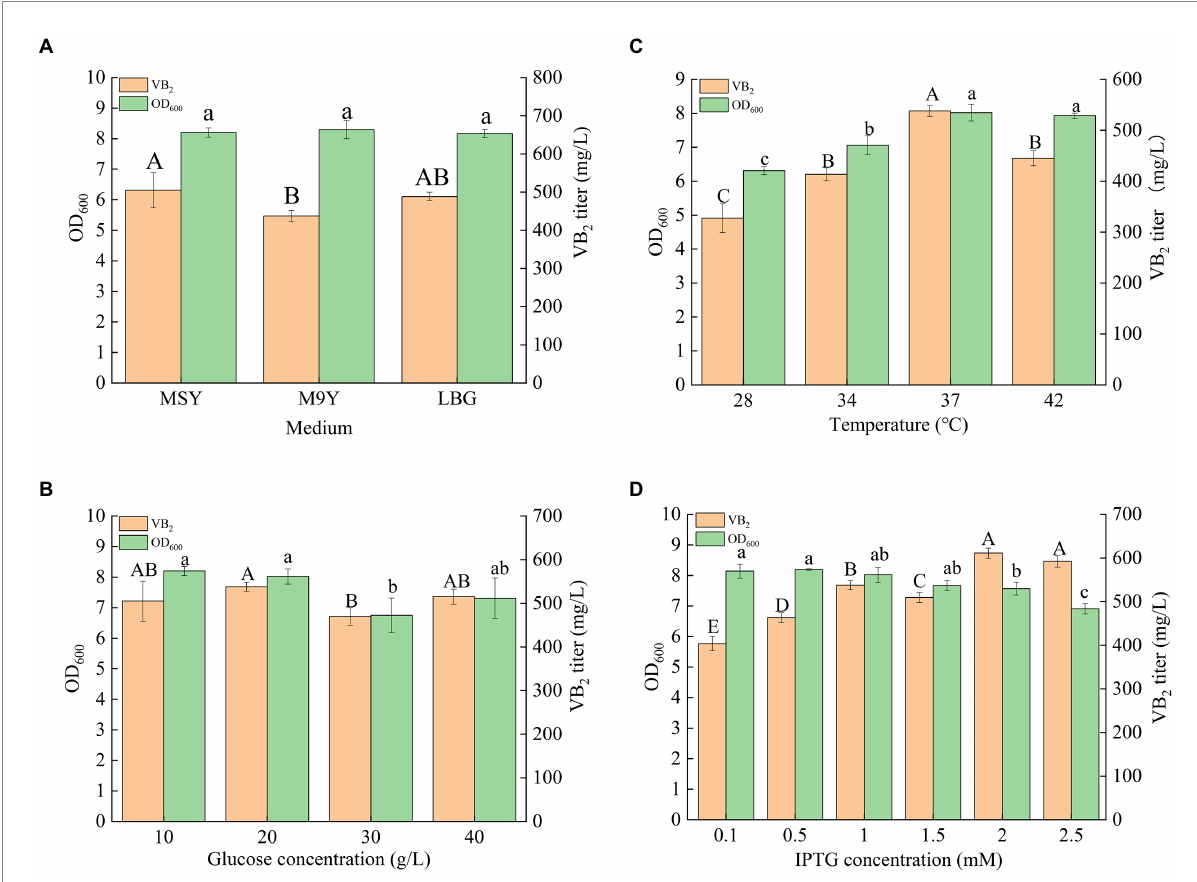
FIGURE 5 Results of the culture condition optimization of the engineered strain R4: (A) fermentation results in different culture media; (B) fermentation results with MSY medium containing different concentrations of glucose; (C) fermentation results at different temperatures; (D) fermentation results at different IPTG concentrations ( p < 0.05). Letters indicate significant